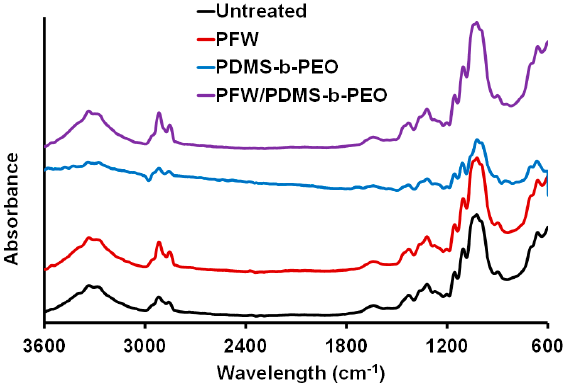
Figure 4. FTIR-ATR spectra of untreated FP, PFW, PDMS- b -PEO, and PFW/PDMS- b -PEO treated FP samples.